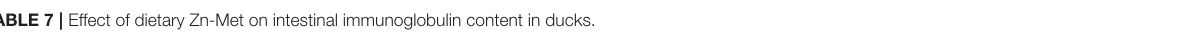
AVONA Linear Quadratic